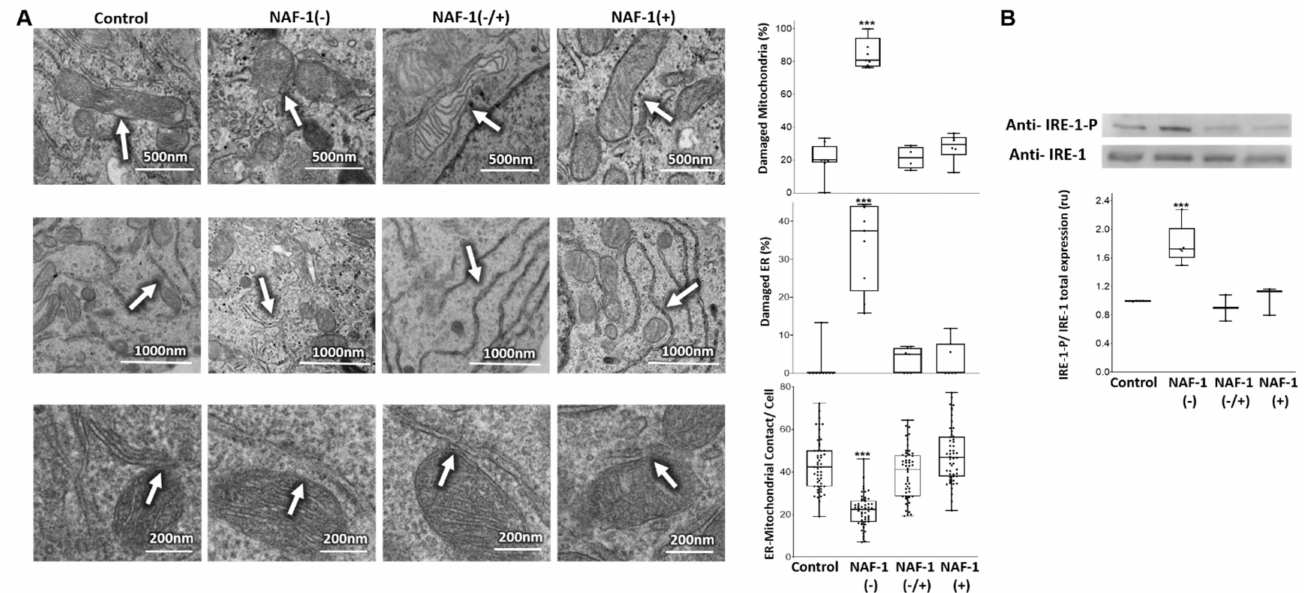
Figure 2. Mitochondrial and ER structural alterations and phosphorylation of IRE-1 in INS-1E cells with repressed or overexpressed NAF-1 levels. ( A ) Representative TEM images (left panels) and statistical analysis (right graphs) of alterations in mitochondrial (top), ER (middle), and ER-mitochondrial contact points (bottom) structures in control, NAF-1( − ), NAF- 1( − /+), and NAF-1(+) cells. ( B ) Protein blots (top) and graph (bottom) showing the ratio between IRE-1 and phosphorylated IRE-1 (IRE-1P) in INS-1E cells expressing different levels of NAF-1. The results are presented as box-and-whisker plots and include all data points measured in three different experiments. *** p < 0.001, compared to control; Student’s t -test, N = 600 for mitochondria and mitochondrial-ER contact and N = 900 for ER. Abbreviations: IRE, serine/threonine-protein